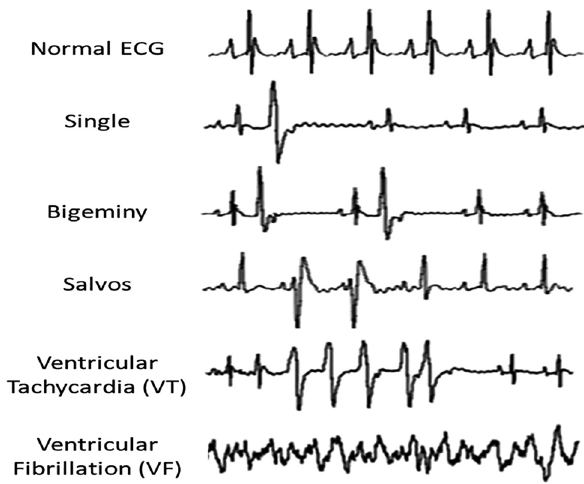
Figure1: TypesofmyocardialarrhythmiasaccordingtotheLambeth convention. PVC, premature ventricular complexes; VT, ventricular tachycardia; and VF, ventricular fibrillation. Single beats, bigeminy and salvos were considered as